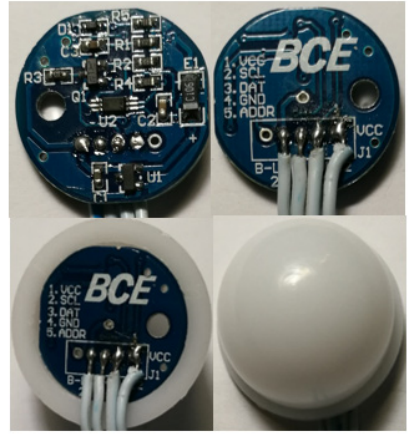
Figure 3. BCE illuminance sensor.